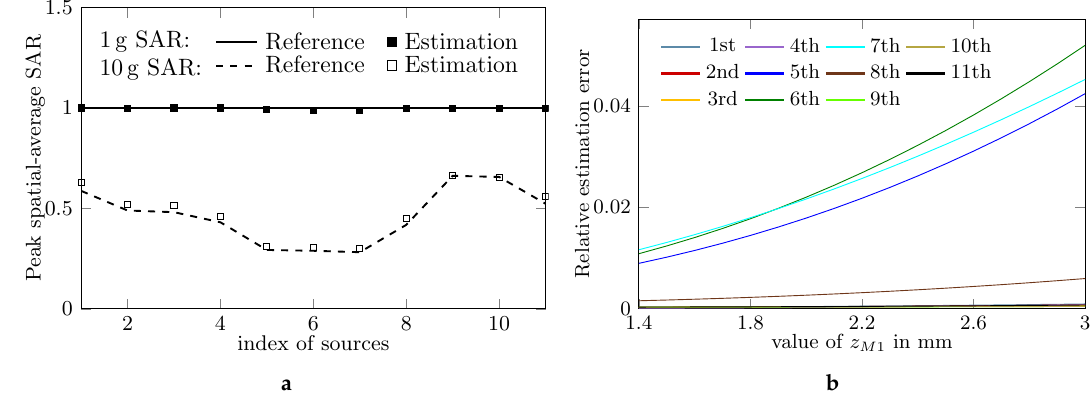
Figure 2. Setting horizontal and vertical grid spacing as 4mm and 2mm, respectively, ( a ) shows estimated 1g and 10g SAR when z M 1 = 1.4mm, ( b ) the relative estimation error with increasing z M 1